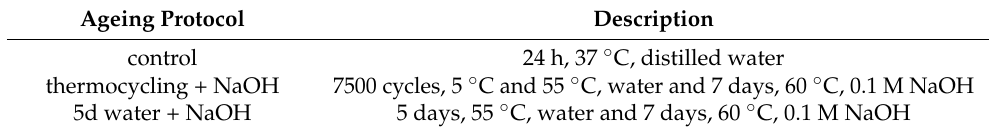
Table 2. Description of selected ageing protocols used to evaluate tested